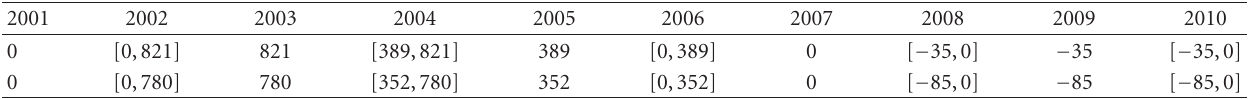
Table 1: The corresponding constraints of similarity model in 10 years.